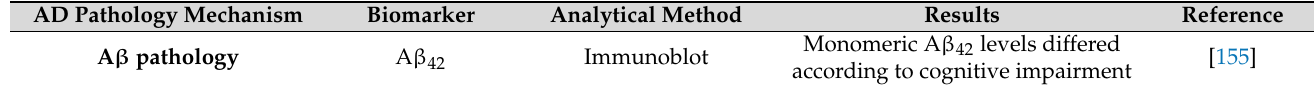
Table 10. Summary of core AD biomarkers in